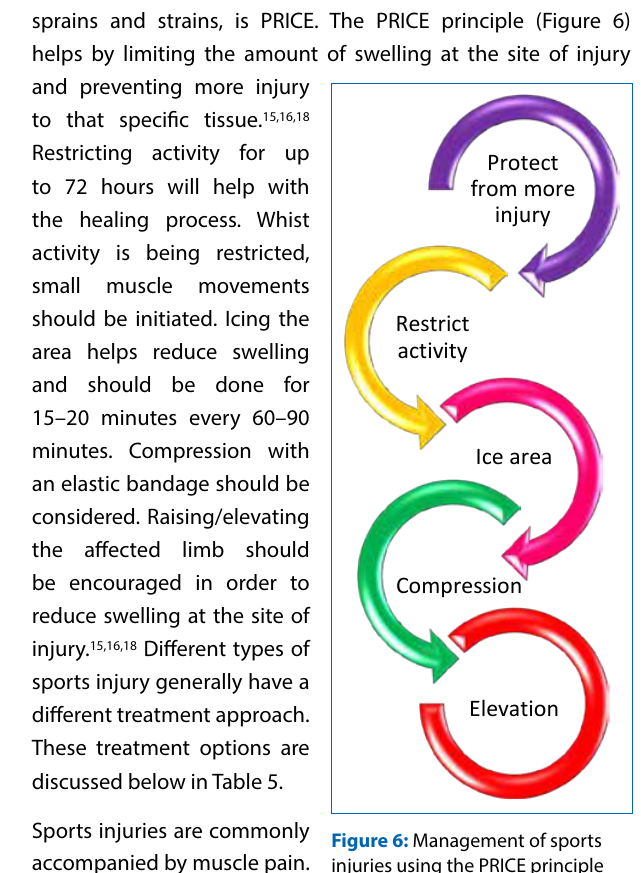
Figure 5: Components to effectively prevent and manage injury